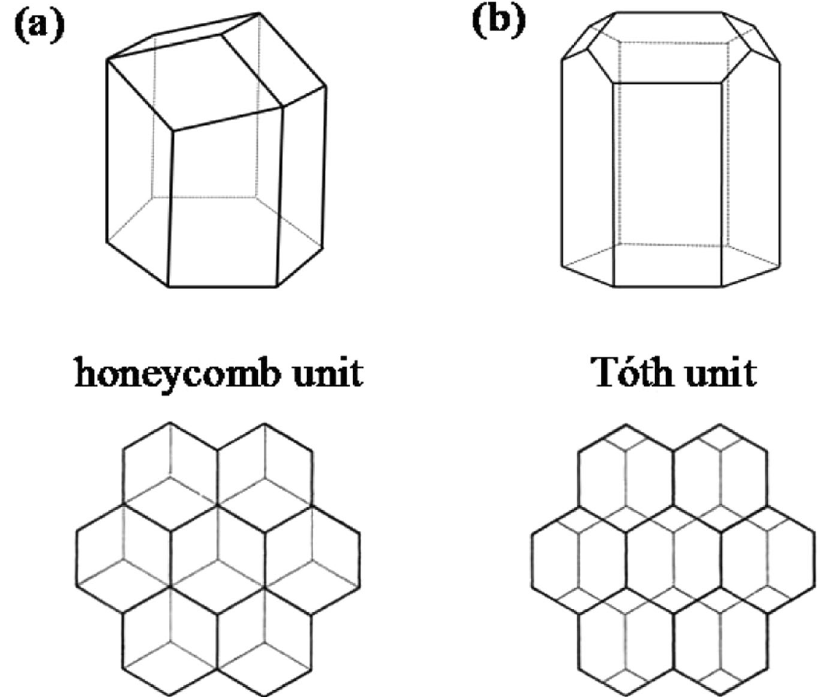
Figure 1. ( a ) A honeycomb unit and a view of such units projected on a plane; ( b ) A Tóth unit and a view of such units projected on a